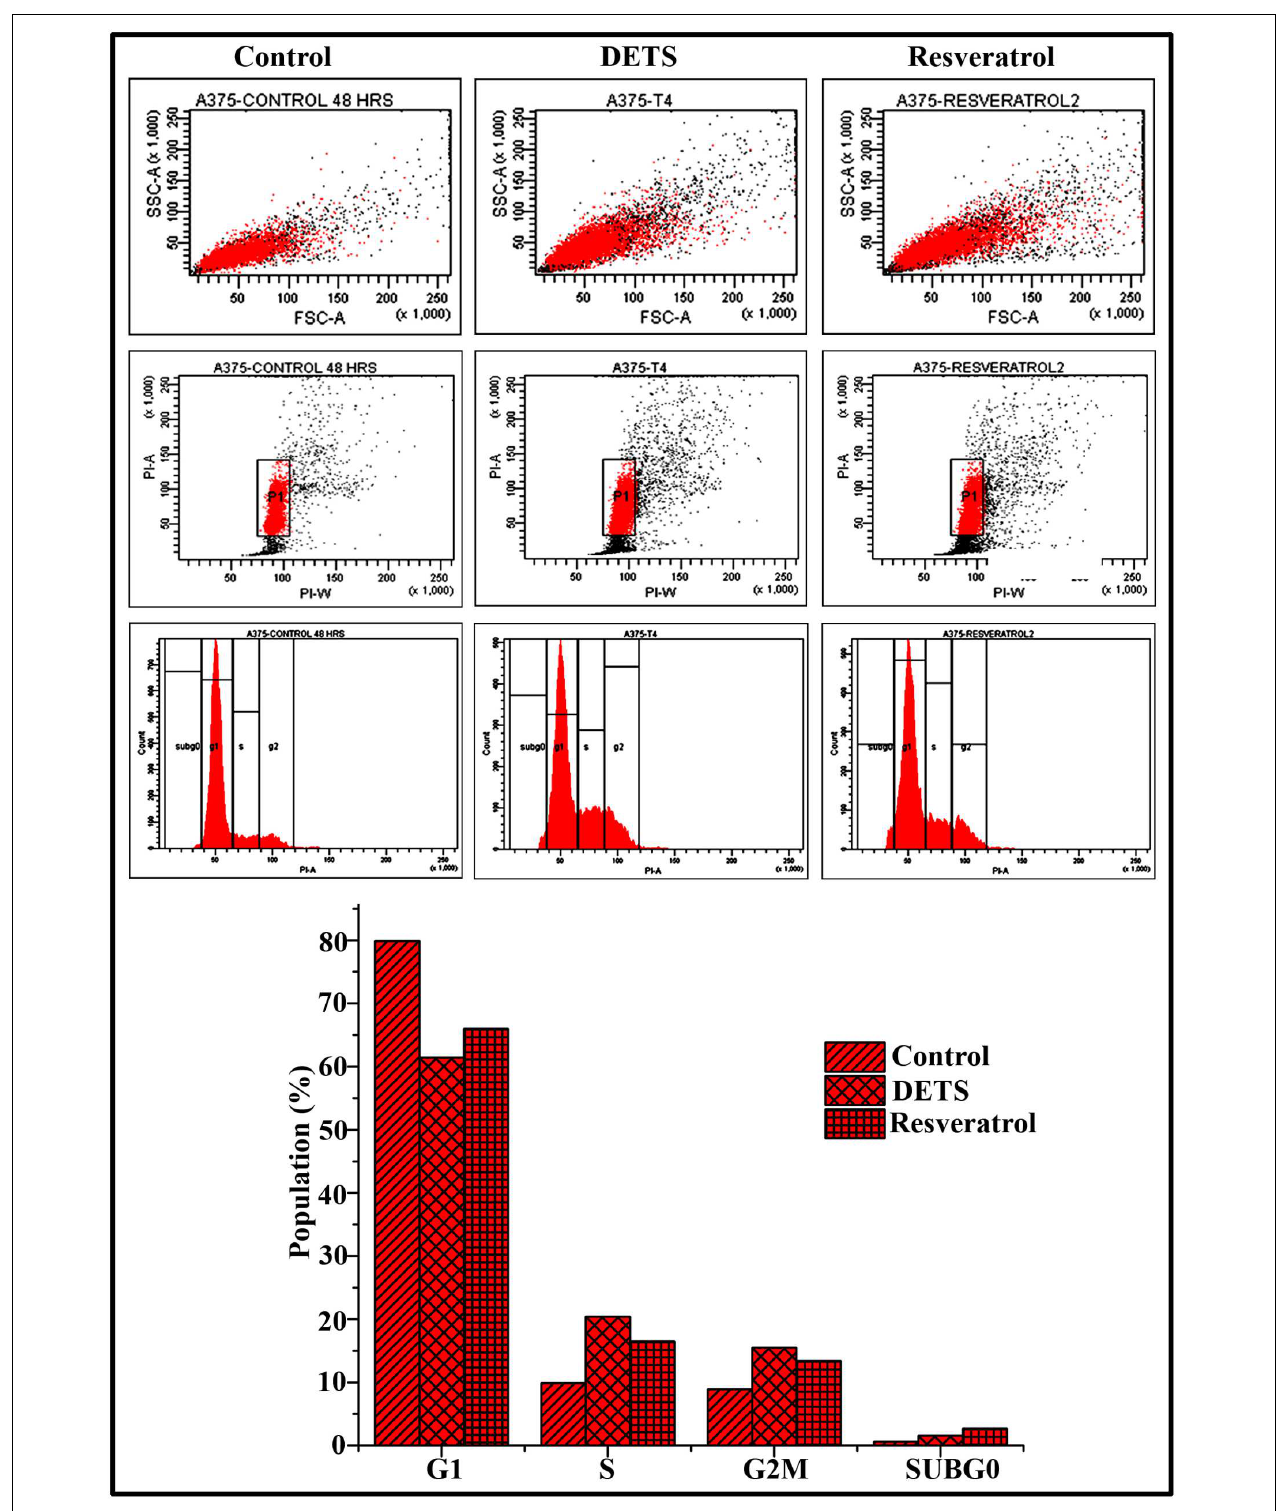
FIGURE 6 | DETS induce S-G2 M cell cycle arrest in A375 cells. Cells were harvested after 48 h of sample treatment, fixed in alcohol, stained with propidium iodide, and assayed for DNA content by flow cytometry. Representative histograms indicate the percentages of cells in G1, S, G2/M and sub G0 phases of the cell cycle. The percentage of cells with sub-G0 DNA content was taken as a measure of the apoptotic cell population. Resveratrol (20 µ M) was used as positive control. The data provided is representative of three independent experiments. Bars with different characters are statistically different at p , 0.05 level.